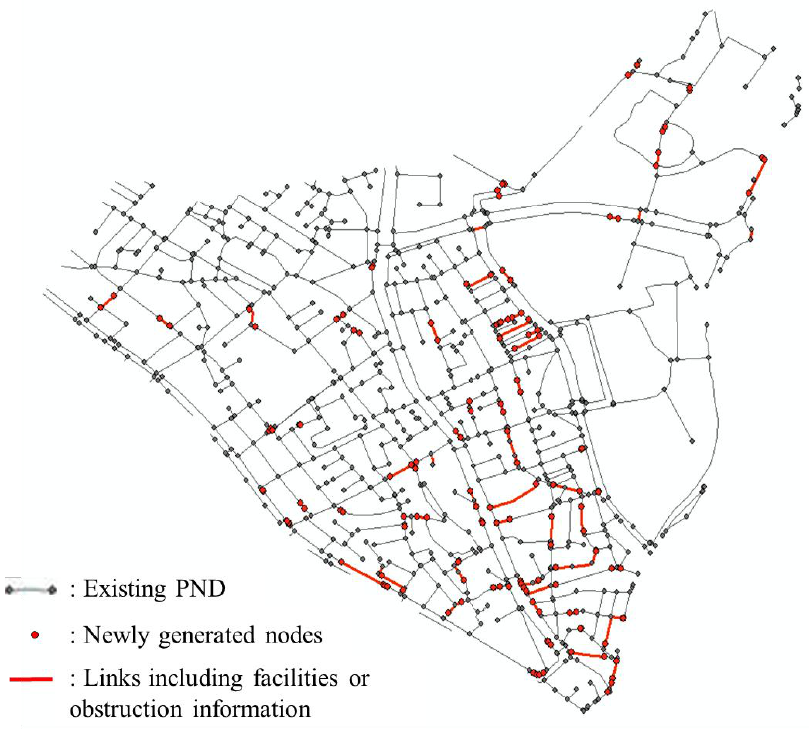
Figure 13. New PND of the test site integrated with the facilities and obstructions obtained by GPS trajectory of